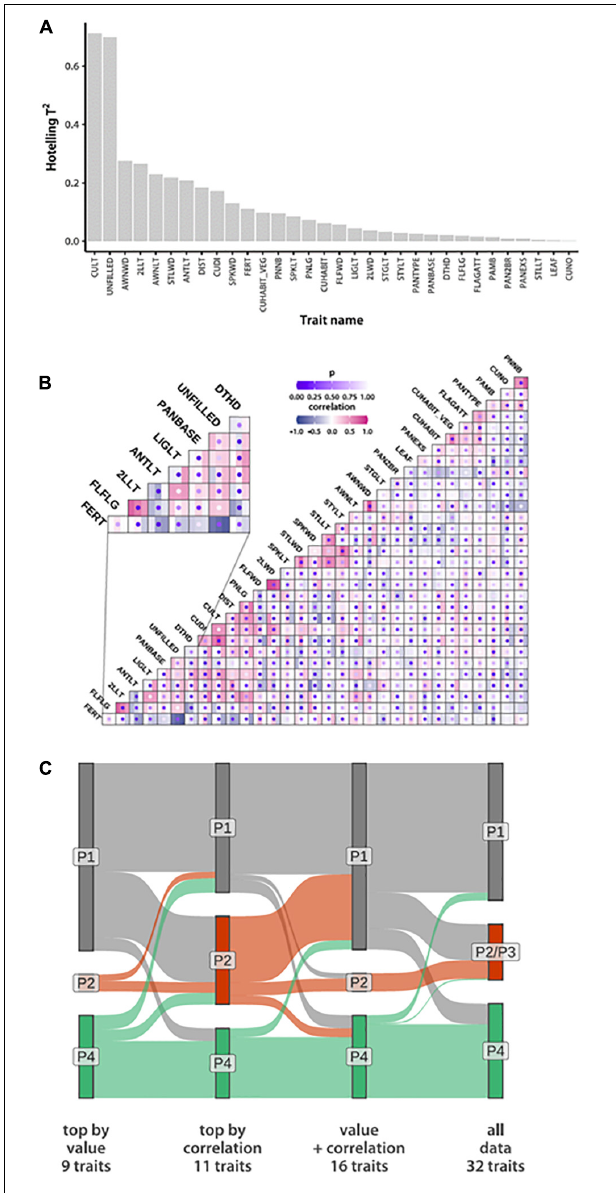
FIGURE 2 | Phenotypic identifiers of group divergence based on the IRRI data. (A) Traits sorted by the strength of the association of their values to N G = 4 group assignments based on Hotelling T 2 values (B) Among-trait correlation estimates within each phenotypic group. Squares mark trait pairs, with the three bars within each square colored according to correlation magnitude in the three phenotypic groups. Dots represent probabilities of observing the correlation differences by chance (lower probabilities reflect high confidence of correlation difference). The inset shows a segment of the plot in more detail. (Trait acronyms and actual values are in Supplementary Table 7 ) (C) Sankey plot comparing accession membership across groups inferred from trait subsets listed in Table 1